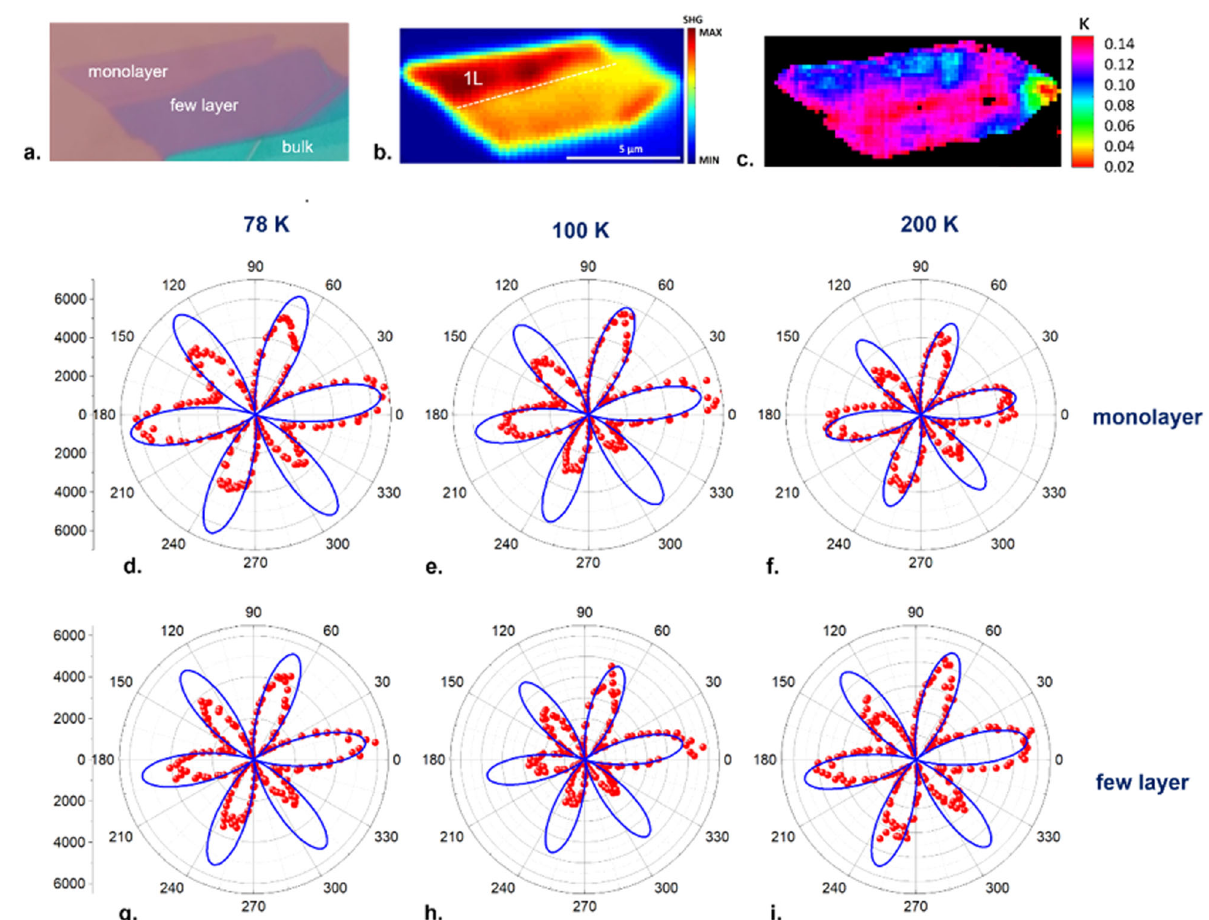
Fig. 5 Valley population imbalance imaging for monolayer and few-layer WS 2 . a Optical image of a WS 2 fl ake consisting of monolayer, few- layer and bulk regions. b SHG intensity mapping of the WS 2 fl ake at 78 K. c Imaging of VPI in terms of the dimensionless parameter κ at 78 K. d – f Polar diagrams of SHG intensity with varying angle φ of incident fi eld polarization at 78, 100, and 200 K for monolayer and g – i few-layer regions. Red spheres correspond to experimental data and the blue line to the fi tting with Eq.